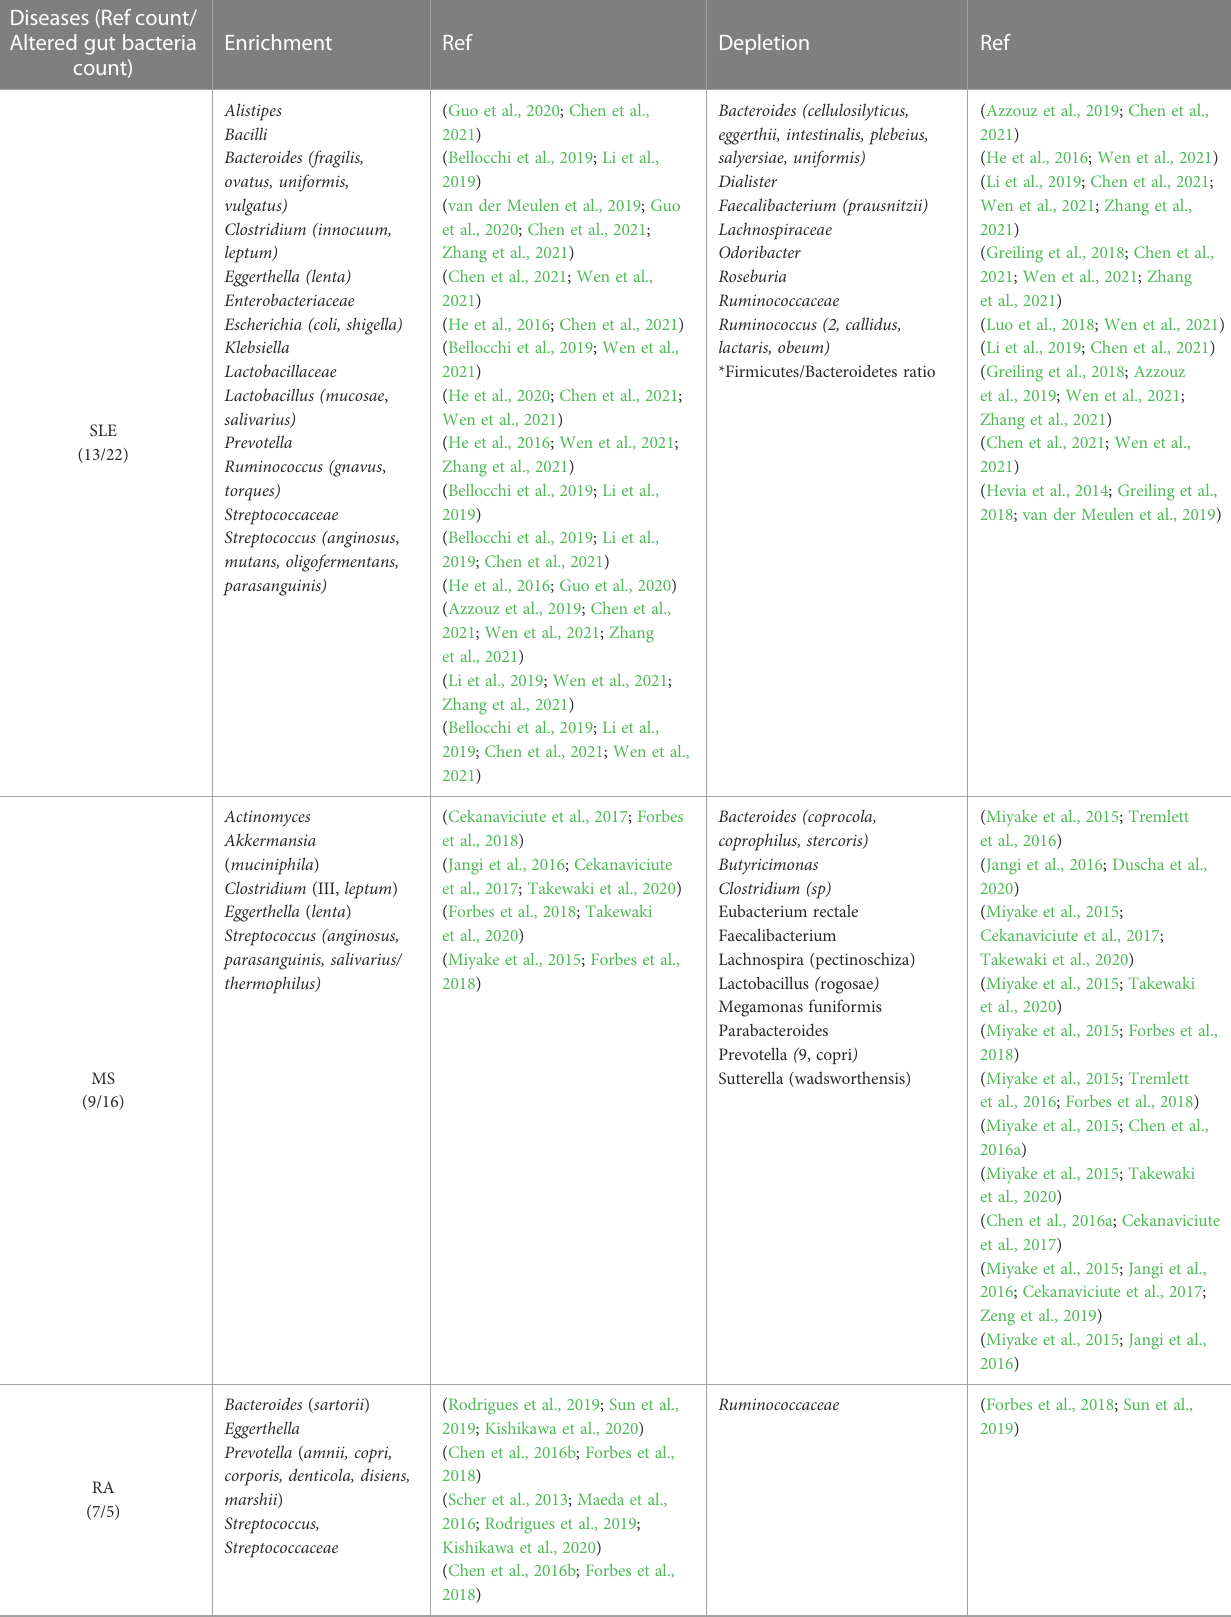
TABLE 1 Commonly altered gut bacteria in gut dysbiosis of patients with autoimmune diseases. Diseases (Ref count/ Altered gut